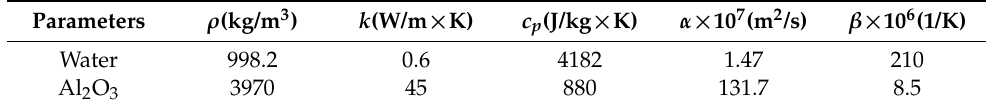
Table 1. The physical properties of Al 2 O 3 and